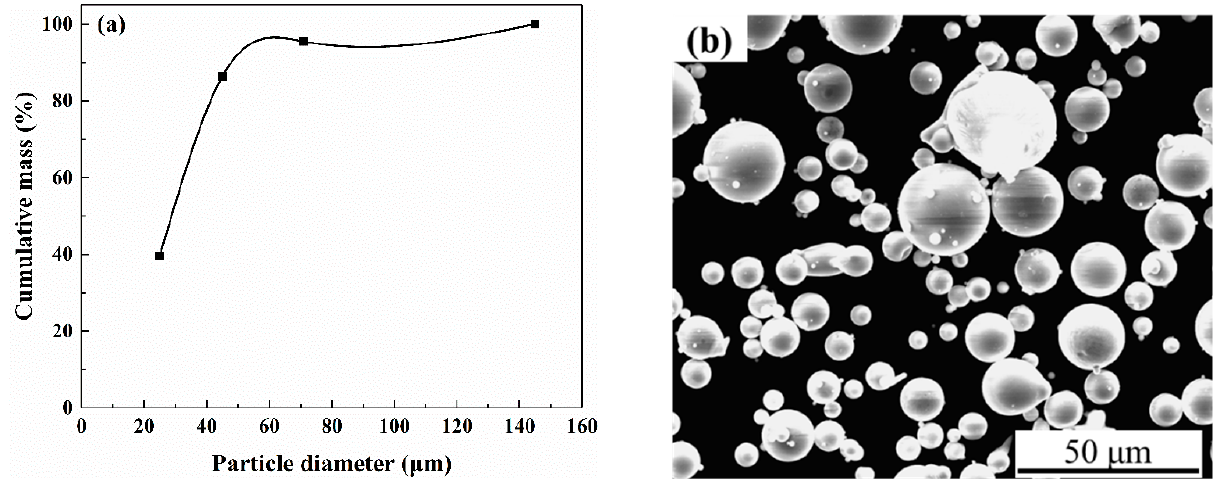
Figure 1. ( a ) Size distribution and ( b ) SEM morphology image of the amorphous powders.